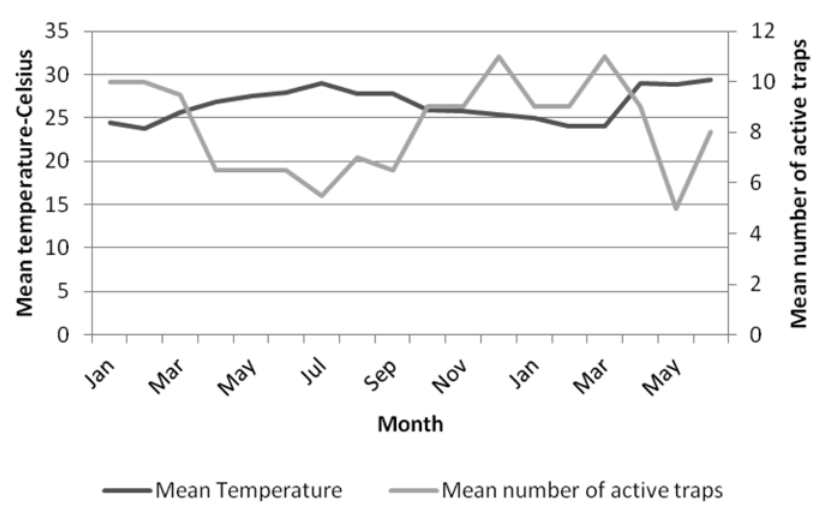
Fig. 2. Mean number of active collection traps (out of 22 total) at the C. formosanus field site in comparison to mean temperature from January 2010 –June 2011.